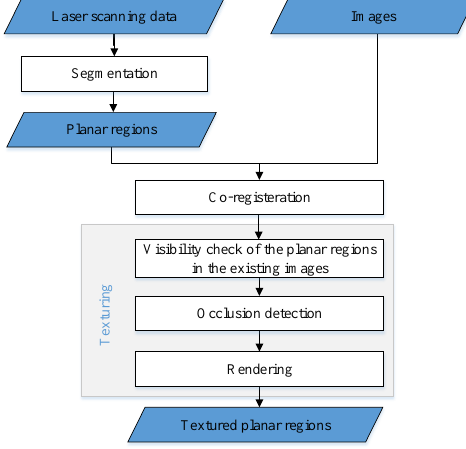
Figure 1. The outline of the proposed texturing approach